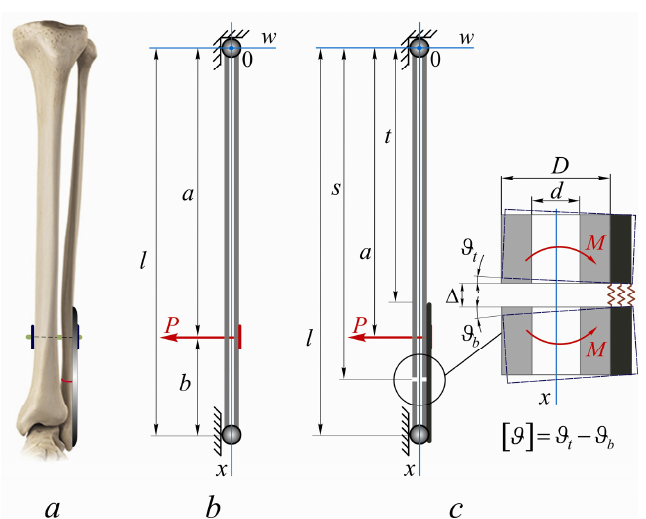
Figure 2. General scheme for combined stable–elastic fibula fixation ( a ), intact fibula model ( b ), and model of the broken fibula, which is blocked with an extracortical plate and elastically fixed using an elastic tightrope ( c